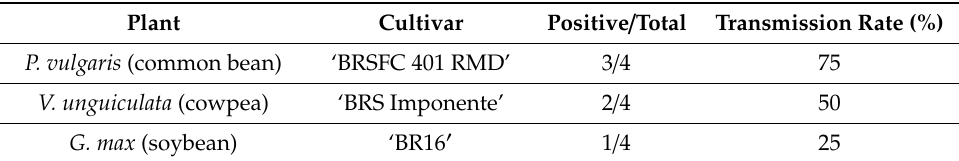
Table 2. BaCV transmission by B. tabaci